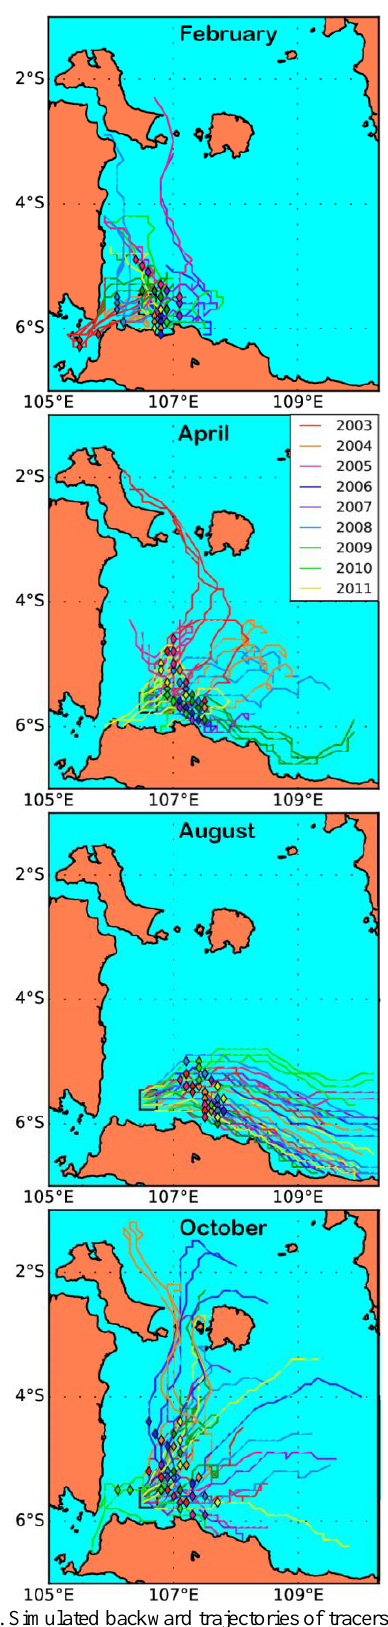
Figure 11. Simulated backward trajectories of tracers starting in the MPA "Seribu Islands", western Java Sea. Different colors show different years, different panels show different months. The diamonds show the position after one week backward simulation, i.e. one week before they would arrive at the